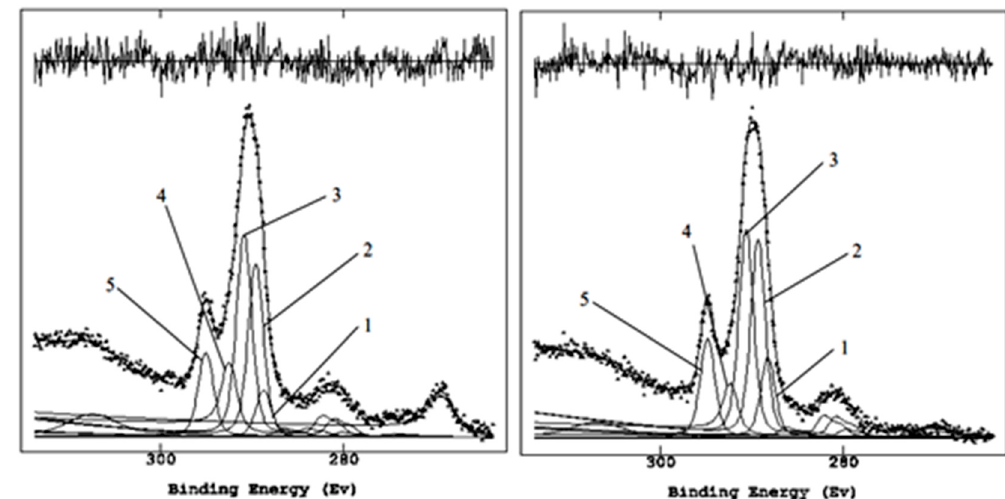
Figure 7. Curve fitting of C1s regions post-1 week (left), post-2 weeks (right). It is essential to underline the disappearance of the peak centered at about 289 eV, attributable to oxalate, partially superimposed on the reference peak of carbonate at 290.0 eV but easily resolved by curve-fitting after the treatment.